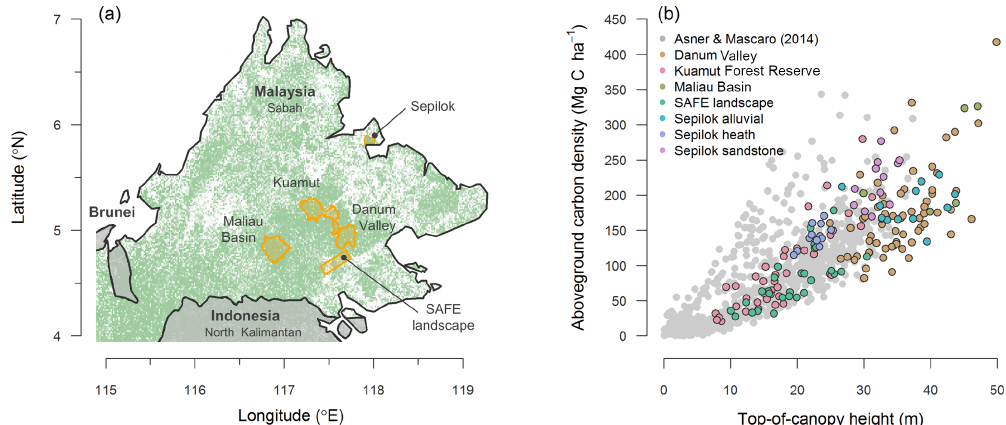
Figure 1. Panel (a) shows the location of the Sepilok and Kuamut Forest Reserve, the Danum Valley and Maliau Basin Conservation Area, and the SAFE landscape within Sabah (Malaysia). Green shading in the background represents forest cover at 30m resolution in the year 2000 (Hansen et al., 2013). In panel (b) , the relationship between field-measured aboveground carbon density and ALS-derived top-of- canopy height found across the study sites (coloured circles, n = 173) is compared to measurements taken mostly in the Neotropics (Asner and Mascaro, 2014; grey circles, n =